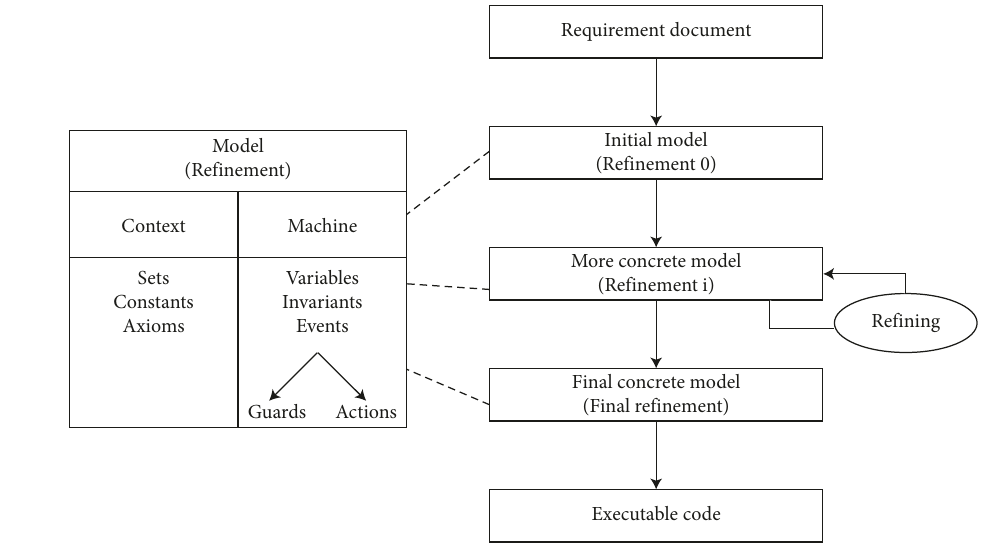
Figure 1: Process of development in Event-B [13].